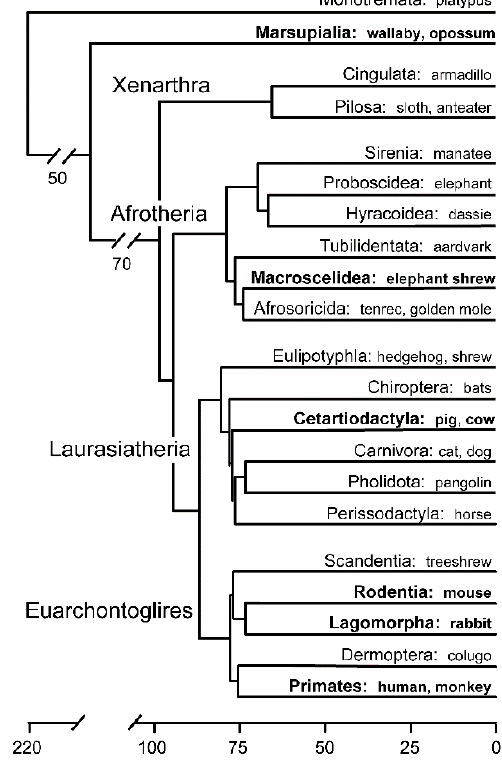
Figure 1. Divergence time (in millions of years) of all extant mammalian orders [2] and their associated superordinal groupings. Groups discussed are shown in bold.